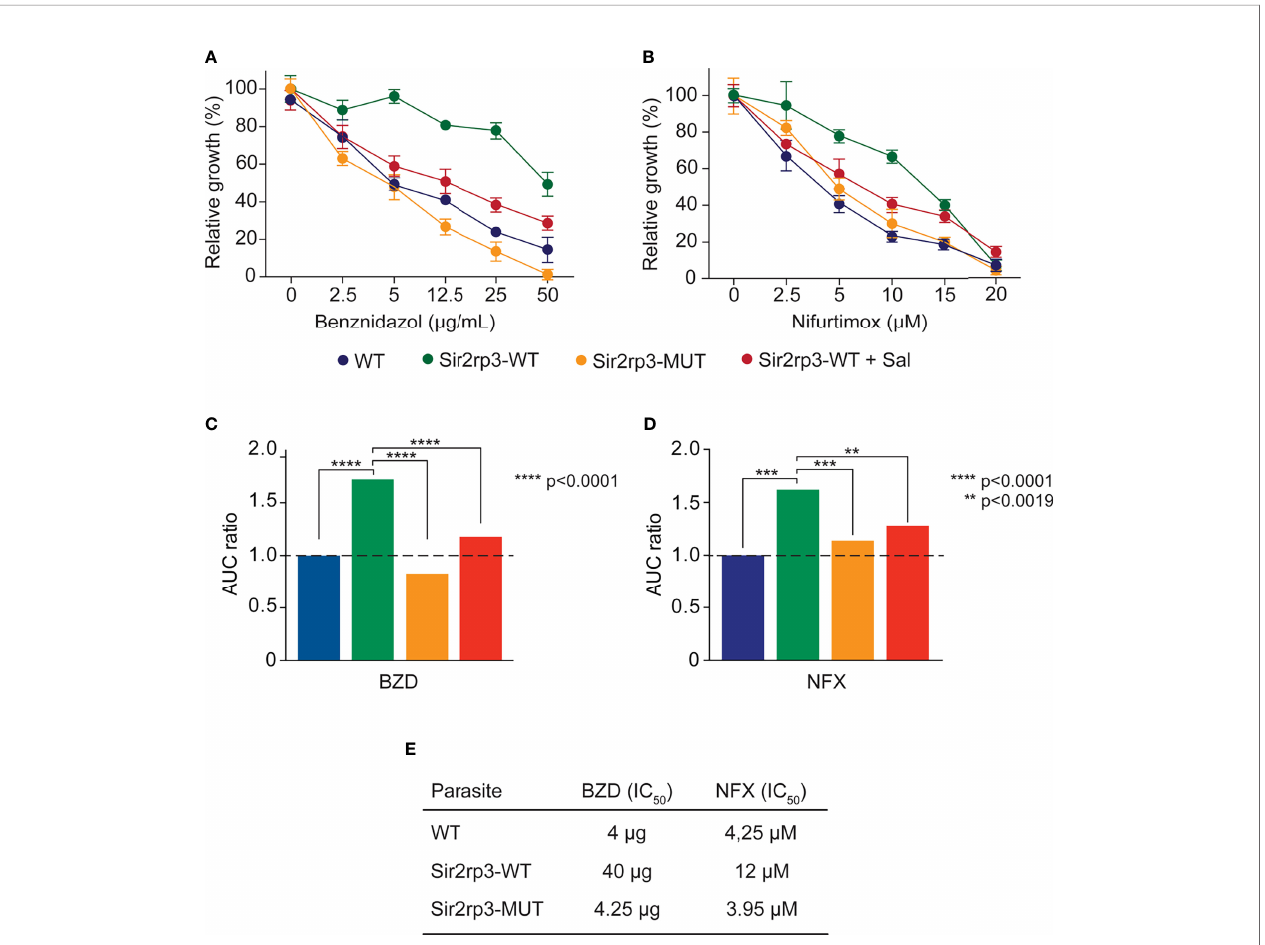
FIGURE 2 | TcSir2rp3 increases parasite resistance to BZD and NFX. Epimastigotes of the indicated lines were incubated with BZD (A, B) or NFX (C, D) and the relative growth determined by the percentage of parasites in the presence or absence of each compound. All the values are mean ± SD of triplicates. To better visualize the effects, (B, D) show the area under the curve (AUC) of the data shown in (A, C) . (E) IC 50 of BZD and NFX of the WT, Sir2rp3-WT, and Sir3rp3-MUT cell lines. The IC 50 values were calculated based on the growth curve obtained in (A, B)